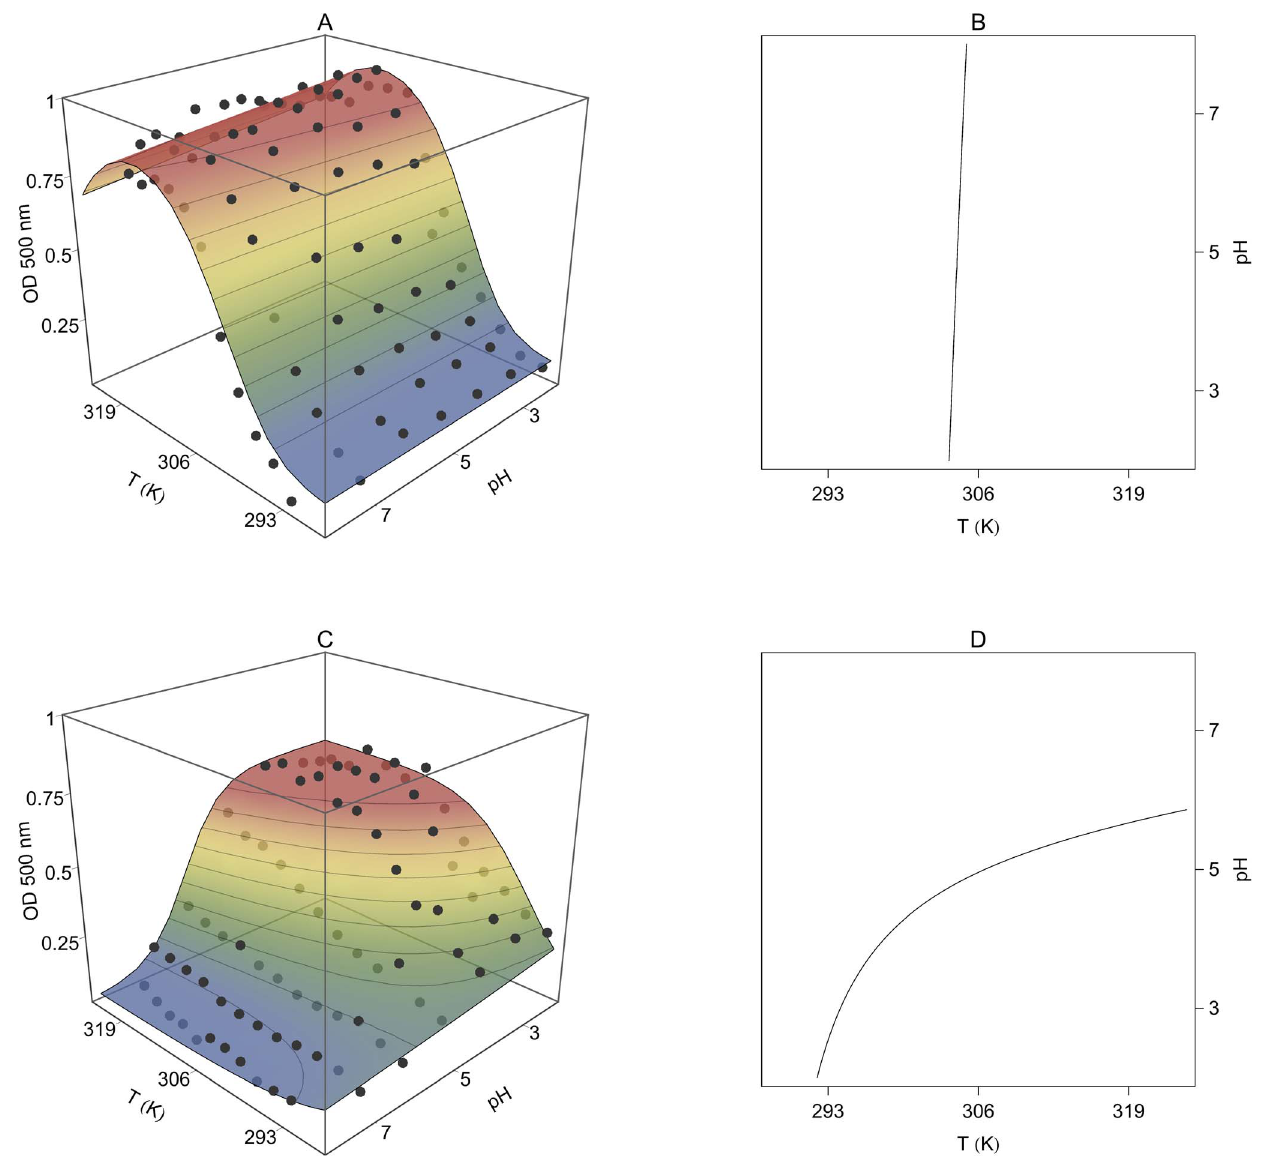
Figure 7. Optical density (OD) variation of PNIPA/AA nanohydrogels as a function of pH and temperature. PNIPA(5) (A) and PNIPA- 20AA(5) (C) nanohydrogels were previously swelled in distilled water (12.5 mg mL 2 1 ) at 25 u C. The surface represents the fitting of the experimental data with the Equation 19. Figures B (PNIPA(5)) and D (PNIPA-20AA(5)) show pH-T phase diagrams, in which the critical line marks the temperature and pH conditions at which the nanohydrogel begins to undergo the volume phase transition.